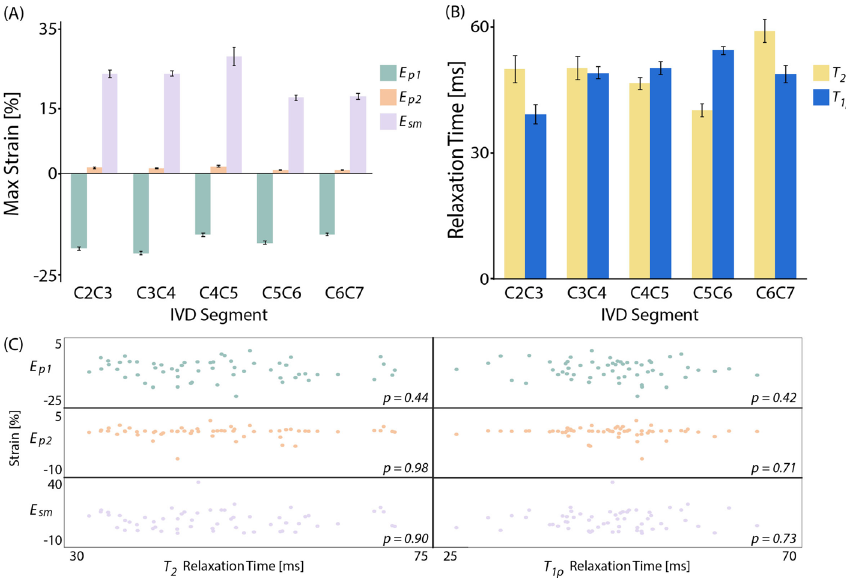
Figure 6. Relaxometry-based structure did not correlate with dualMRI-based mechanical function. ( A ) The absolute maximum 10% of each strain measure ( E p1 , E p2 , E sm ) represents the functional response extremes by each IVD to simple flexion–extension. The maximum strains revealed no significant differences across IVD segment (p > 0.01). ( B ) The average monoexponential qMRI (T 2 and T 1ρ ) values were determined at each IVD segment as an indicator for spatial structural. Significant differences in relaxometry data were not found between adjacent discs (p > 0.01). ( C ) Correlations between whole disc strain and relaxation time were not significant (p > 0.01) for any combination (Strains: E p1 , E p2 , and E sm | Relaxometry: T 2 and T 1ρ ). The lack of correlation in a bulk disc analysis suggests both structural and functional data is needed to characterize the IVD in vivo. Error bars represent